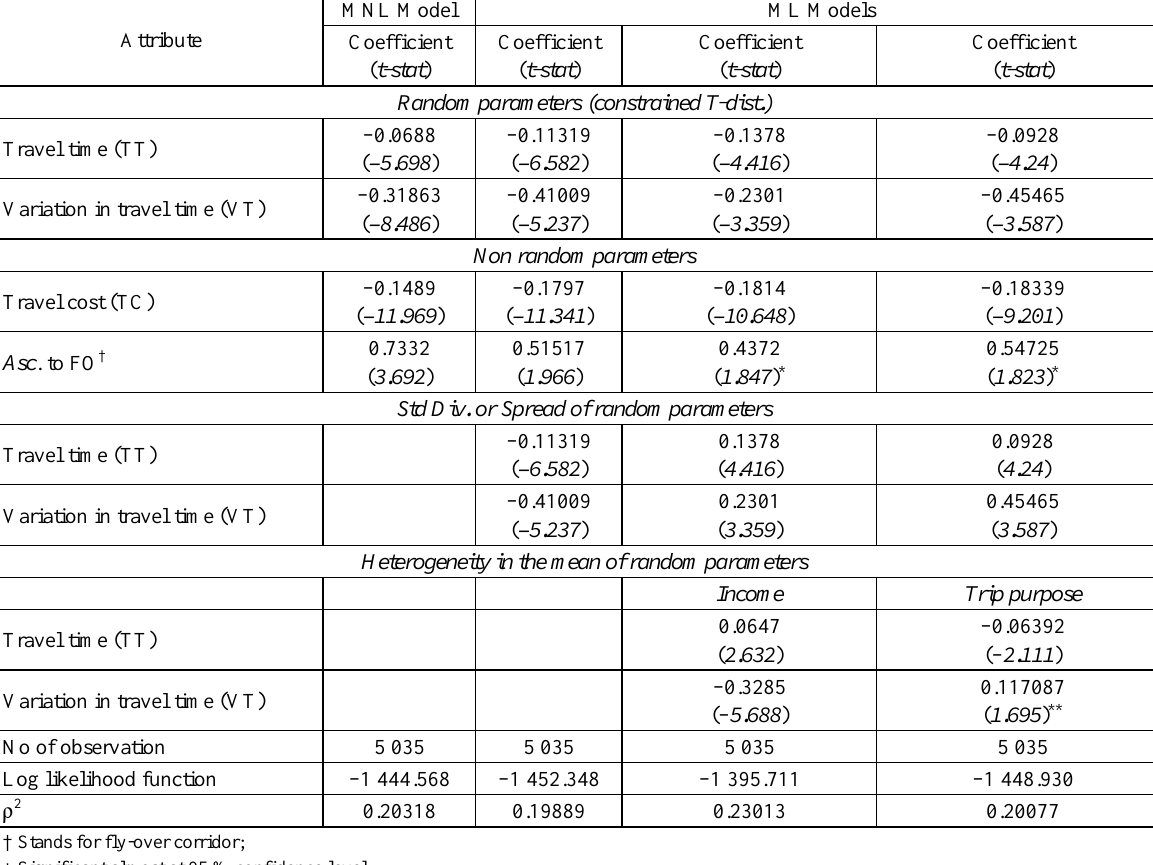
Table 5. Coefficients estimate from MNL and ML techniques for taxi trip makers